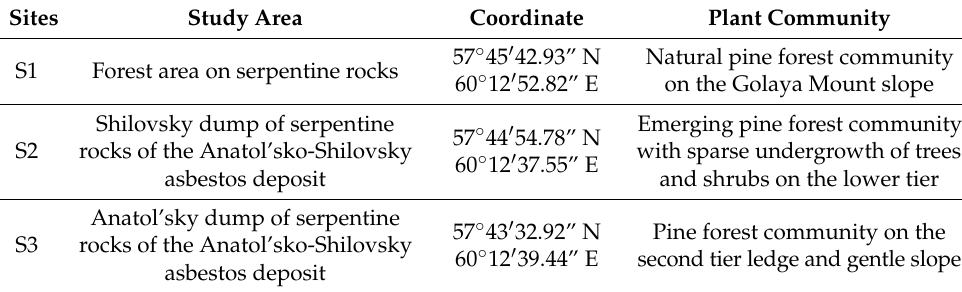
Table 1. Studied sites for sampling of rhizospheric substrate and E. atrorubens